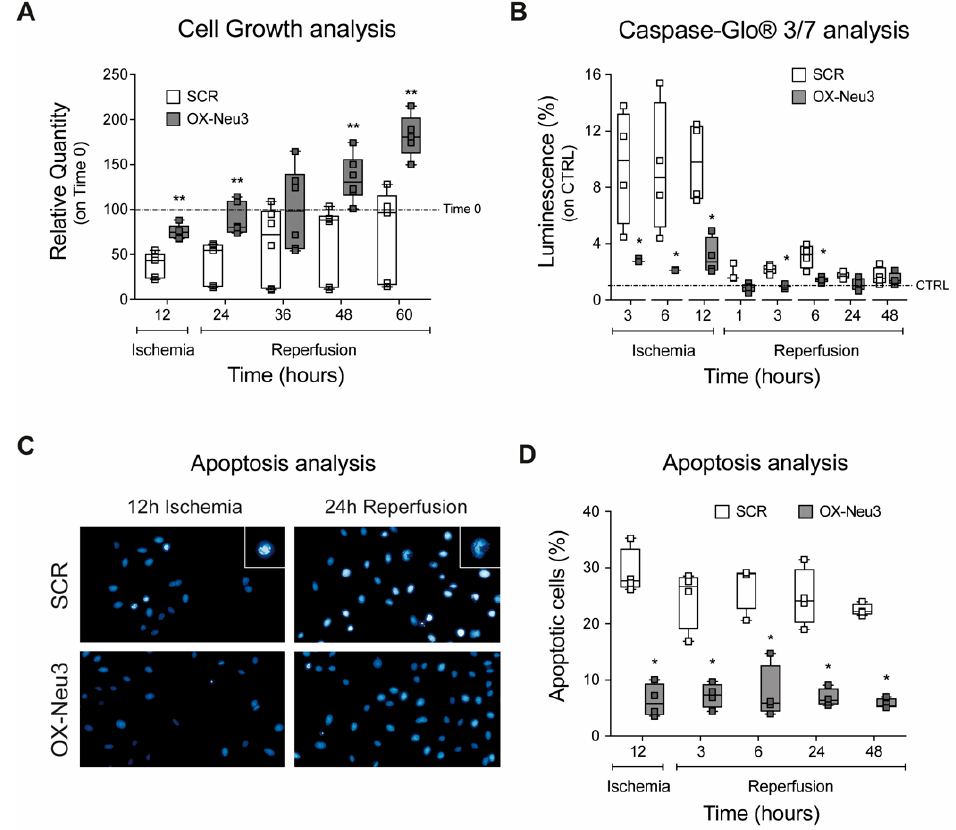
Figure 5. Effects of Neu3 overexpression in H9c2 cells exposed to IRI. ( A ) Cell growth analysis. Data are expressed as relative quantity (%) as compared to both SCR or OX-Neu3 cells at the beginning of IRI treatment ( Time 0 dashed line ) ( B ) caspase 3/7 activation analysis through the Caspase-Glo ® 3/7 assay. Data are expressed as fold change as compared to both SCR or OX-Neu3 cells maintained in standard culture conditions and not exposed to IRI, used as controls ( CTRL dashed line ); ( C ) apoptotic nuclei staining by Hoechst 33,342; White squares represent apoptotic cells magnification; ( D ) apoptosis level analysis expressed as percentage of apoptotic nuclei per total nuclei. Each square in the graphs represent an experimental replicate. Statistical significance was determined by the nonparametric Kruskal-Wallis test by comparing OX-Neu3 cells to SCR cells at any time point analyzed. * p < 0.05; ** p < 0.01.